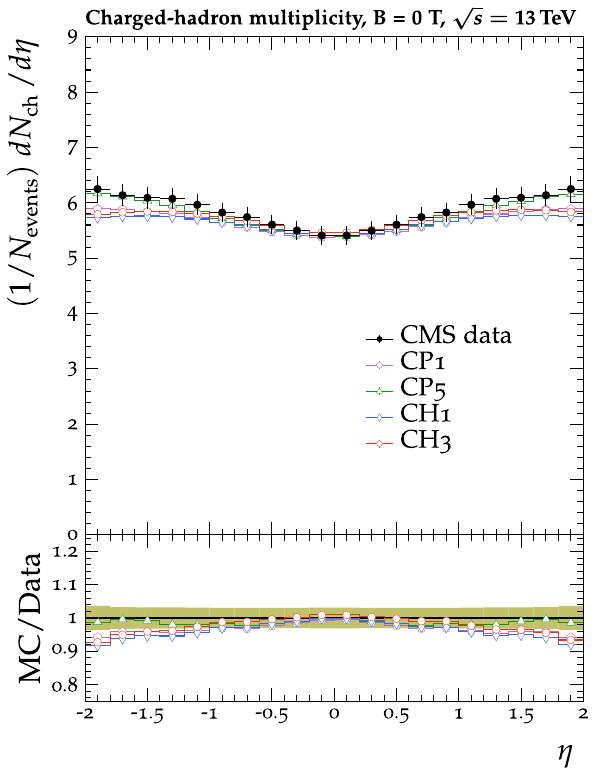
Fig. 8 The normalized d N ch / d η of charged hadrons as a function of η [27]. CMS MB data are compared with the predictions from herwig 7, with the CH1 and CH3 tunes, and from pythia 8, with the CP1 and CP5 tunes. The coloured band in the ratio plot represents the total experi- mental uncertainty in the data. The vertical bars on the points for the different predictions represent the statistical uncertainties Table 3 Parameters of the central, “up”, and “down” variations of the CH3 tune CH3 Down